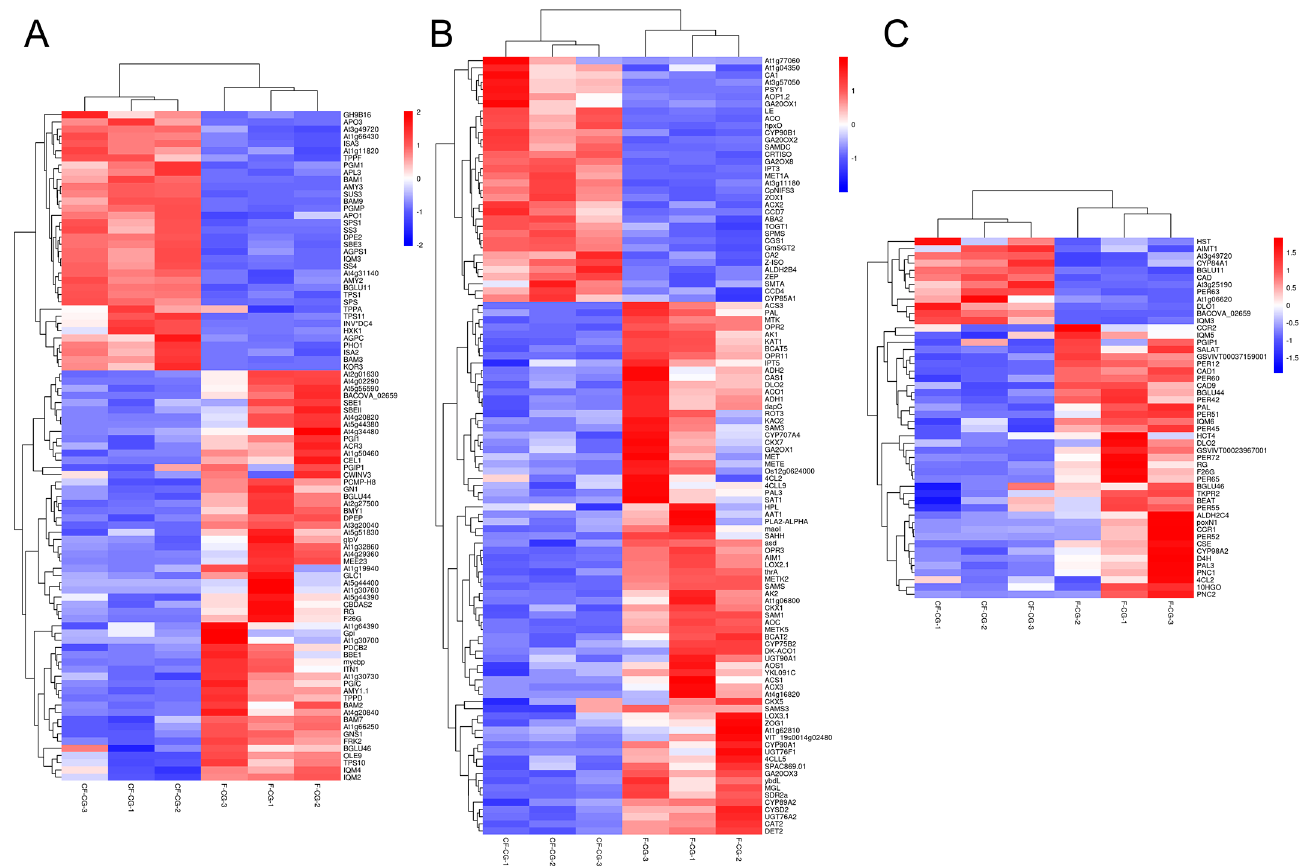
Figure 8. Heat map analysis of differentially expressed genes between CF-CG and F-CG. Red, up- regulated genes; blue, down-regulated genes. ( A ): Heat map analysis of differential genes in starch and sucrose metabolic pathways in F-CG and CF-CG. ( B ): Heat map analysis of differential genes in plant hormone biosynthesis and signal transduction pathways in F-CG and CF-CG. ( C ): Heat map analysis of differential genes in the phenylpropane metabolic pathways in F-CG and CF-CG.